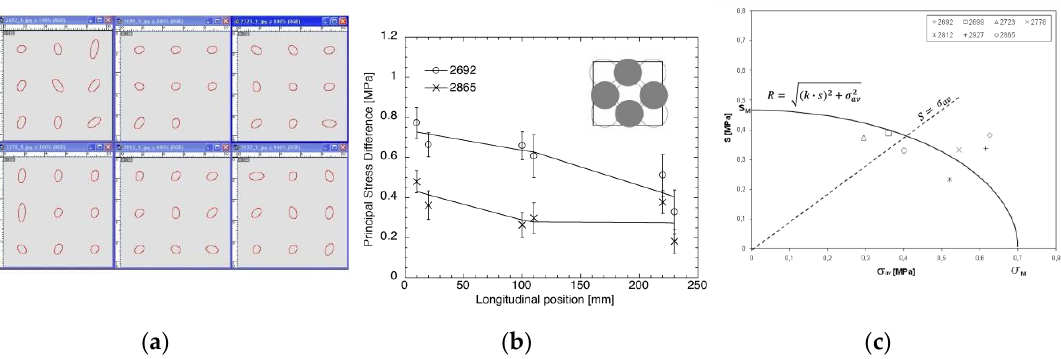
Figure 4. ( a ) The ellipticities evaluated by conoscopy on six cross sections. ( b ) The average residual stress measured at different positions along the length of the samples. ( c ) By the measurement of the residual stress, an indication of the whole quality can be achieved; this schematically represents the region of quality acceptance following the index reported on the graph (used with permission from Copyright Clearance Center/Elsevier, [39]).